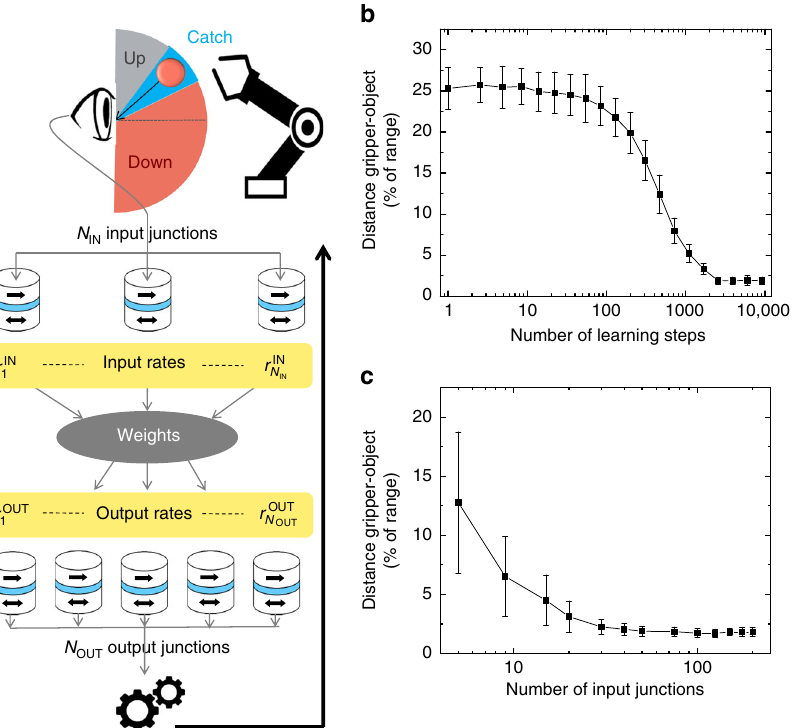
Fig. 3 Learning to transfer information between two interconnected populations. a Schematic of the system and associated learning process. b Distance between the gripper and the object (i.e., grasping error) versus the number of learning steps (populations of 100 junctions). c Distance between the gripper and the object after 3000 learning steps as a function of the number of junctions in the input population. The output population has 100 junctions. For all fi gures, each data point corresponds to the average over 50 trials and the error bar to the associated standard